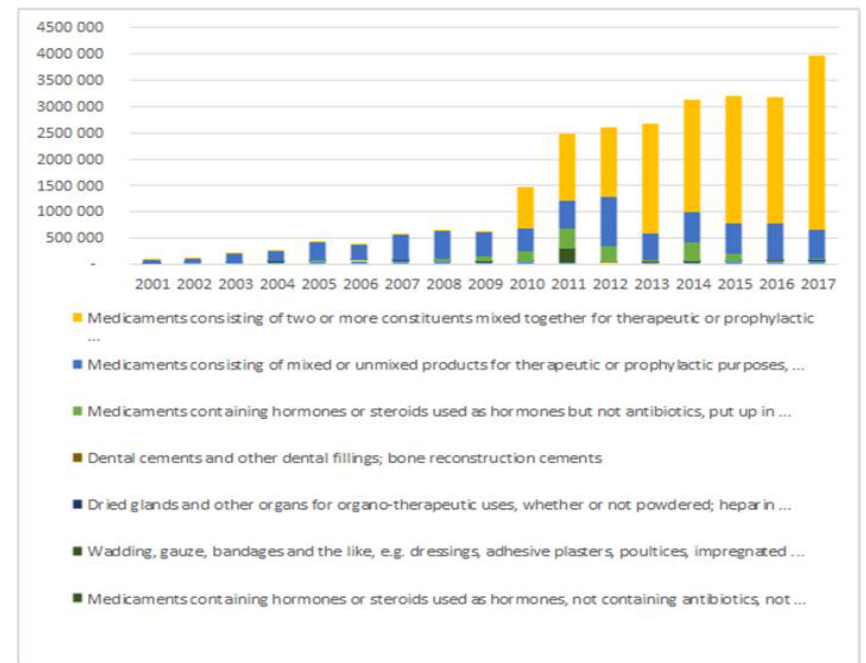
Figure 2. Exports of pharmaceutical products from Israel to the EU (by product